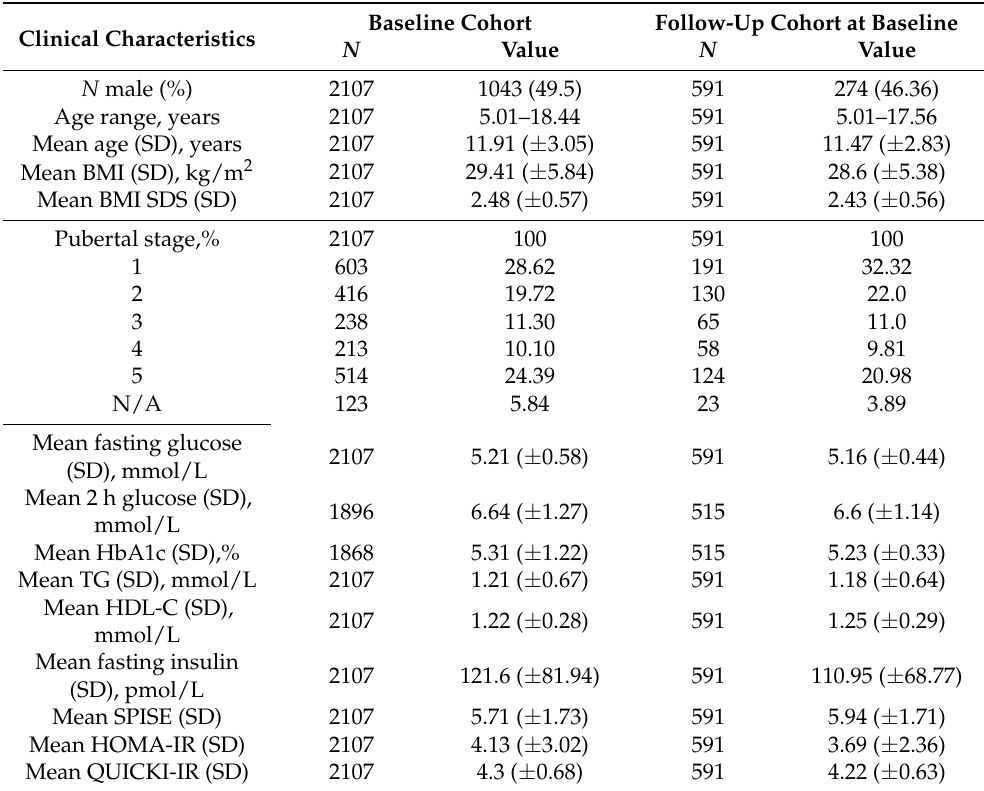
Table 1. Clinical characteristics of cross-sectional baseline cohort and longitudinal follow-up cohort at